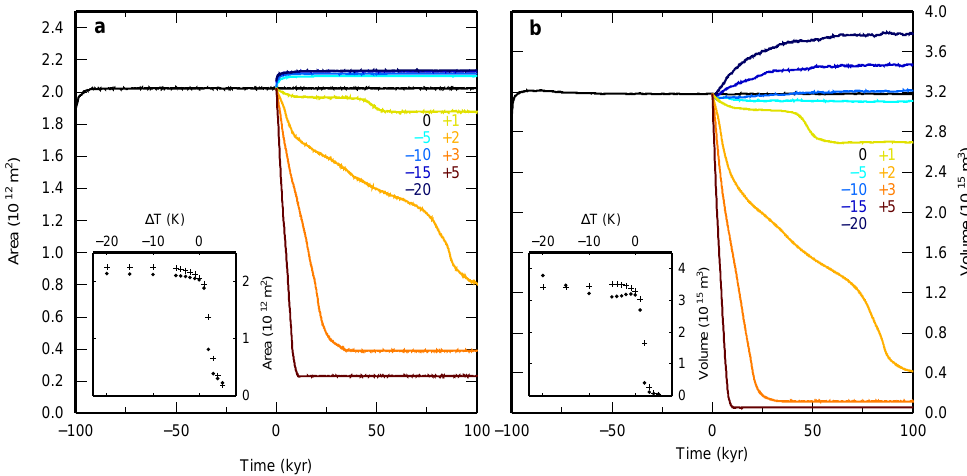
Fig. 11. Time series of (a) ice sheet area and (b) volume resulting from temperature perturbation experiments in combination with the SMB gradient method. Insets show scatter plots of area and volume as function of temperature perturbations using the SMB gradient method (dots) and using the PDD method (crosses).